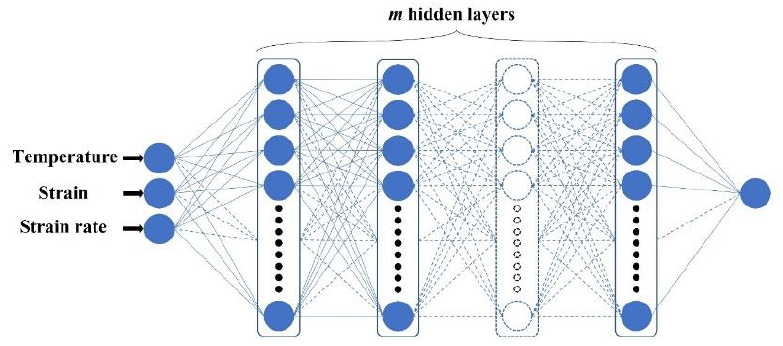
Figure 4. General scheme of the neural network model.